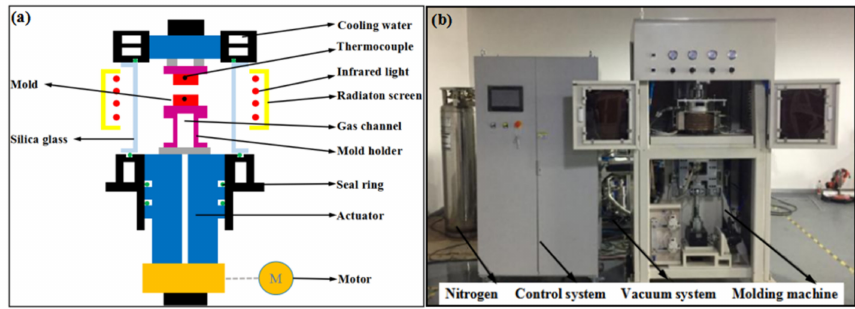
Figure 3. ( a ) Schematic diagram of molding machine system and ( b ) SZU’s